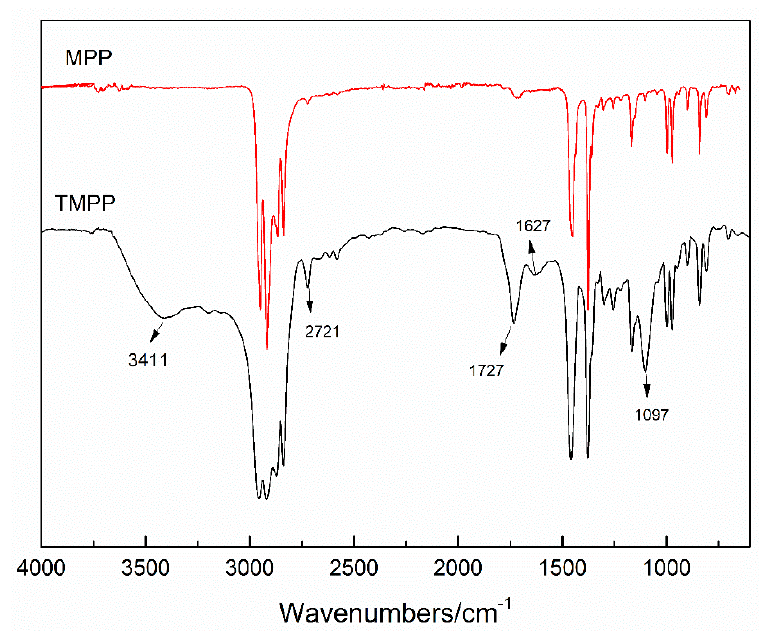
Figure 4. Fourier transform infrared (FTIR) spectra of MPP and TMPP modifiers.